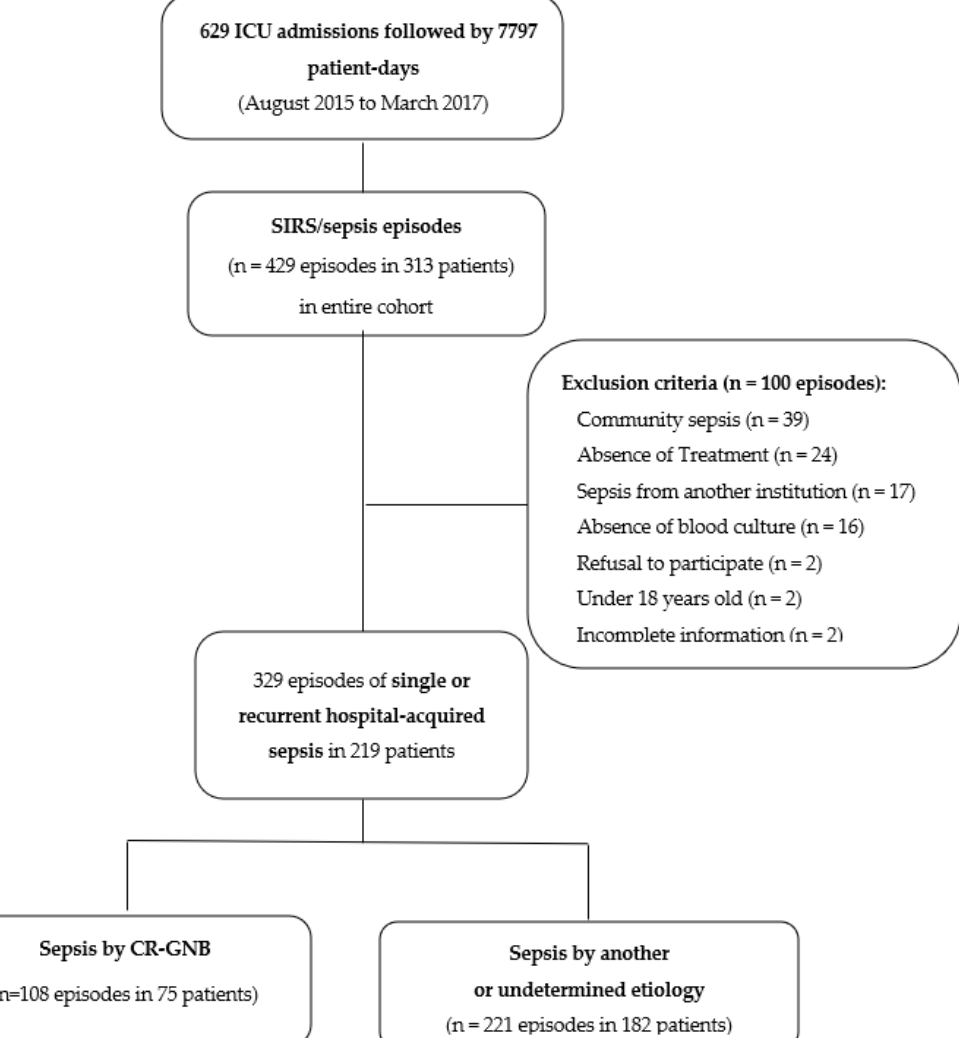
Figure 1. Flowchart of patients included in the study. CR ‐ GNB, carbapenem ‐ resistant Gram ‐ negative bacilli.